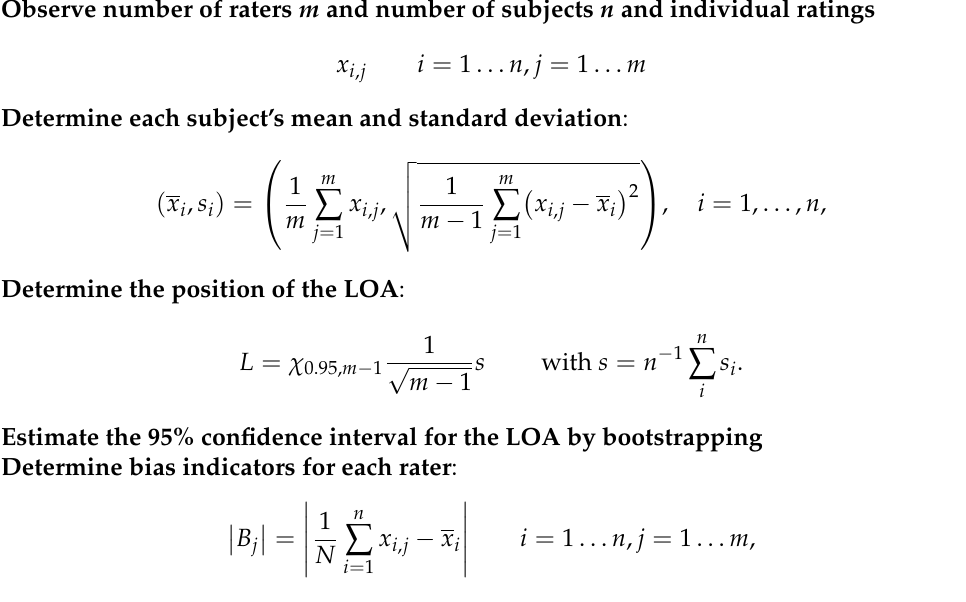
Algorithm 1 E XTENDED B LAND –A LTMAN PLOT FOR MULTIPLE RATERS . Observe number of raters m and number of subjects n and individual